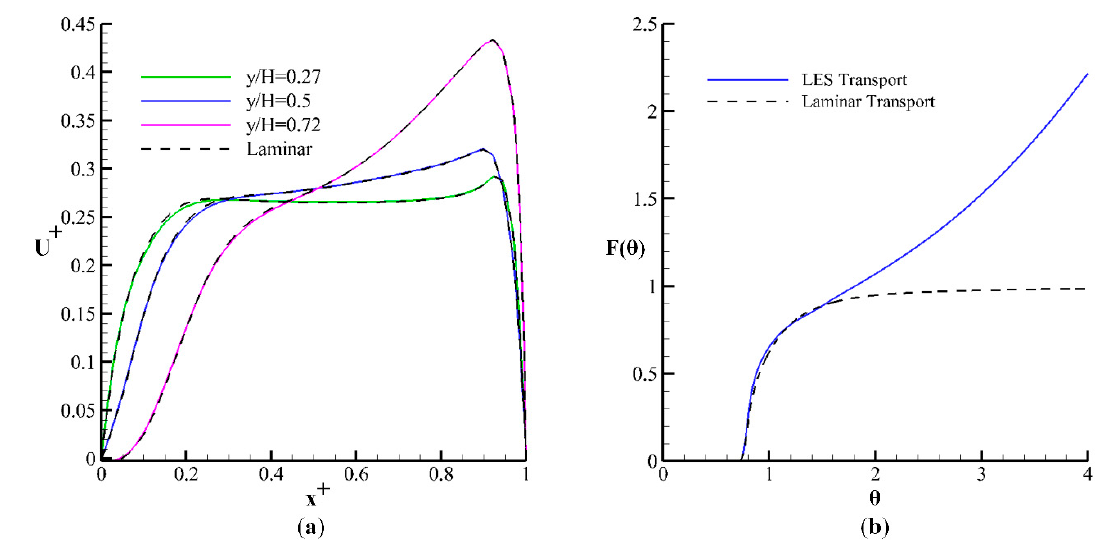
Figure 7. Comparison for the Large Eddy Simulation (LES) and laminar solutions of ( a ) flow and ( b ) transport results.